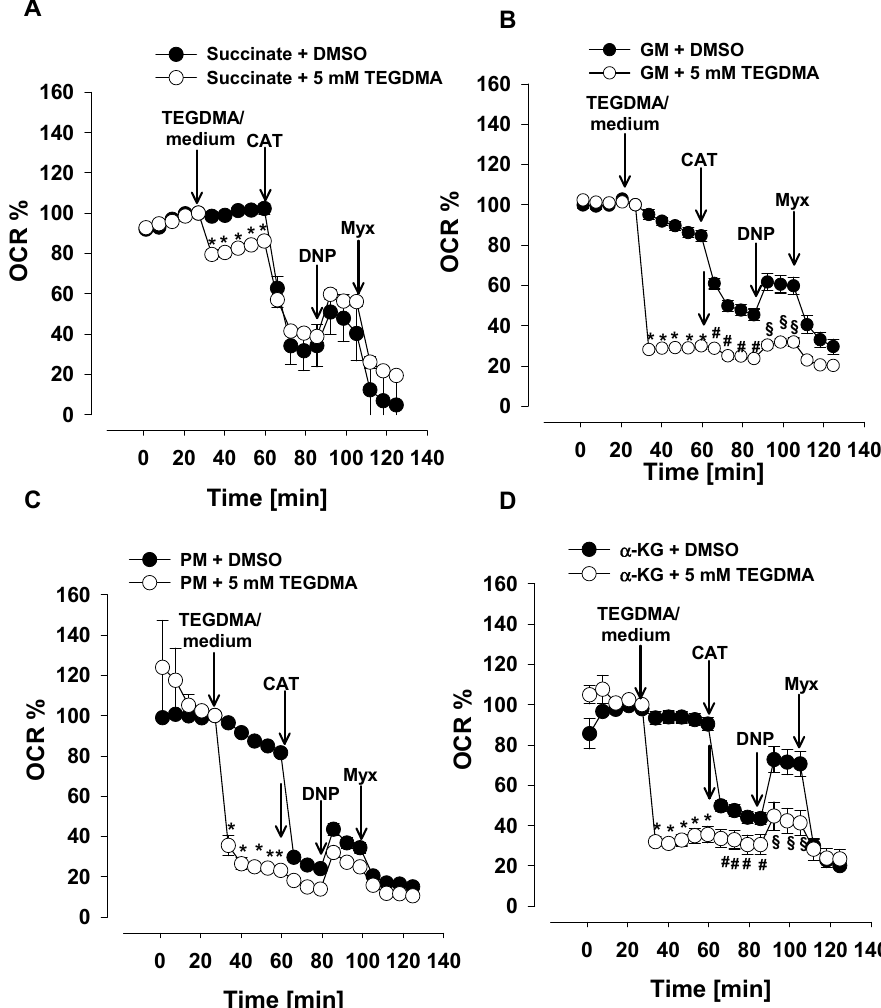
Figure 2. Relative oxygen consumption of permeabilized DPSC respiring on succinate ( A ), glutamate plus malate ( B ), pyruvate plus malate ( C ) and α -ketoglutarate ( D ). Cells were permeabilized prior to the experiment, as described under Materials and Methods. Respiratory substrates and ADP (4 mM) were added to the permeabilized cells before the assay. TEGDMA (5 mM), carboxyatractilozide (CAT; 2 µ M), 2,4- dinitrophenol (DNP; 100 µ M) and myxothiazol (Myx; 1 µ M) were injected as indicated. Each point shows mean values of 16–36 parallel wells ± SEM. OCR (oxygen consumption rate) is expressed as %. The last measurement points before TEGDMA or DMSO injection is considered to be 100%. *, #, § indicate significant di ff erences ( p < 0.05) between TEGDMA-treated and control cells after the TEGDMA, CAT, or DNP additions,